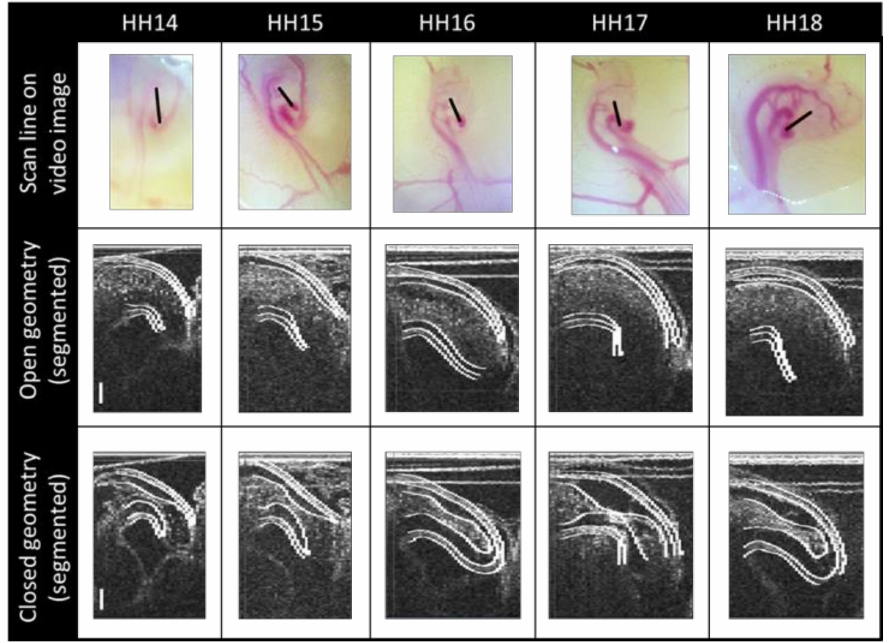
Figure 3. OCT image segmentation. First row : The longitudinal OCT scan location (black lines) superimposed on images of representative embryos at the stages considered. Subsequent rows : Representative structural OCT images reconstructed from synchronized cross-sectional datasets, with the results of our semiautomatic segmentation algorithm, shown here at a longitudinal section corresponding to the location of the black scan lines. Both open and closed OFT configurations are shown for each stage to illustrate the expansion and contraction of the OFT walls during the cardiac cycle which allows flow from the ventricle while blocking most backflow. Scale bars: 150 µ